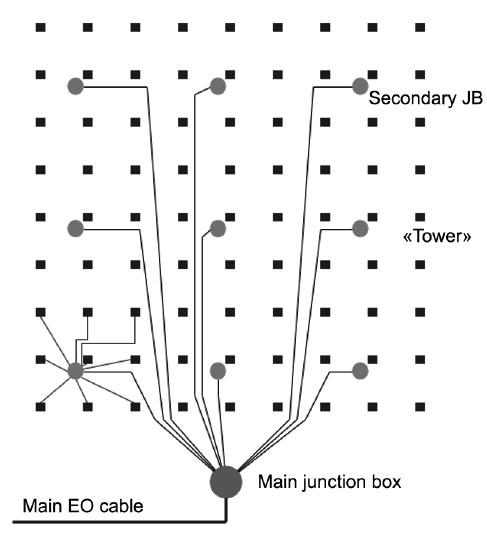
Fig. 4. The proposed layout of the km 3 detector. A hierarchical arrangement of Junction Boxes (JBs), a main one connected to the main electro-optical cable and a number of secondary JBs, will allow to concen- trate the data flow coming from the detector structures and, at the same time, distribute the